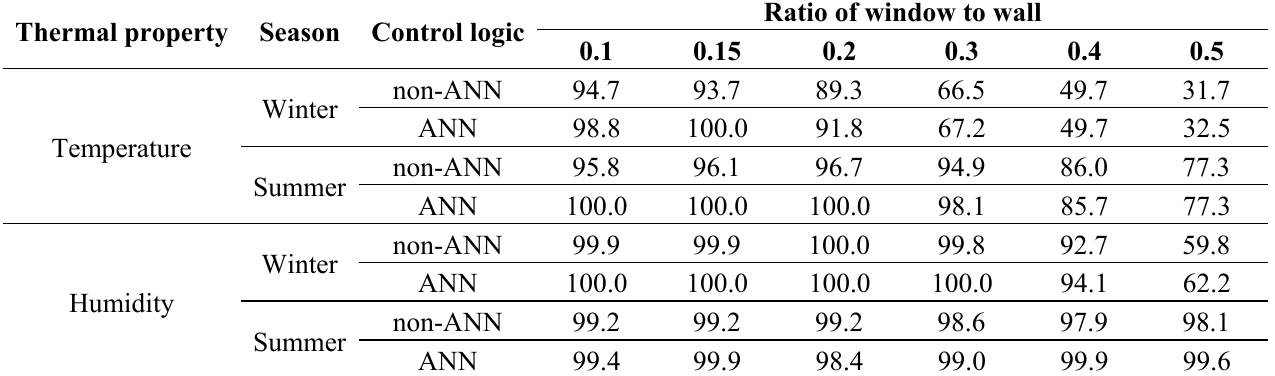
Table 8. Percentage of period within comfortable range according to ratio of window to wall (unit: